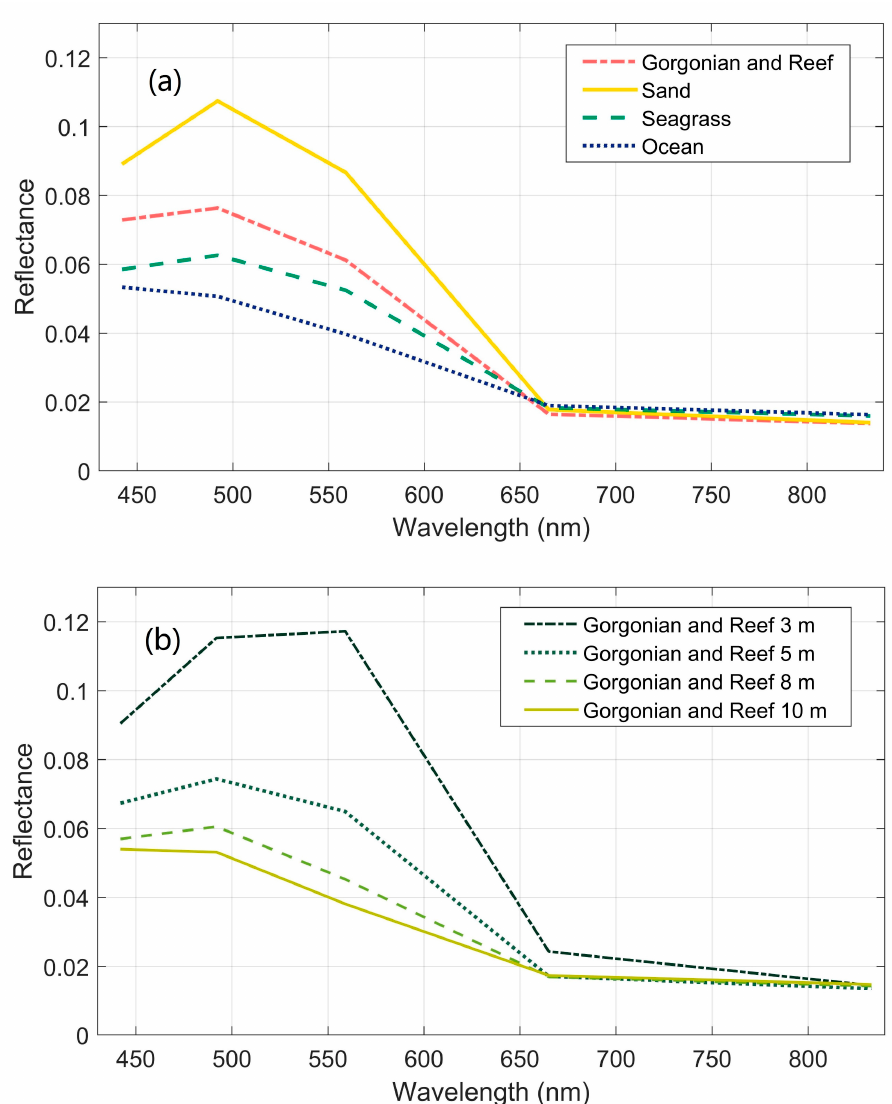
Figure 4. Surface reflectance plots for different benthic habitats. The spectral shape and corre- sponding values represent the signal variations across different benthic targets and varying depths in the Sentinel-2 reflectance